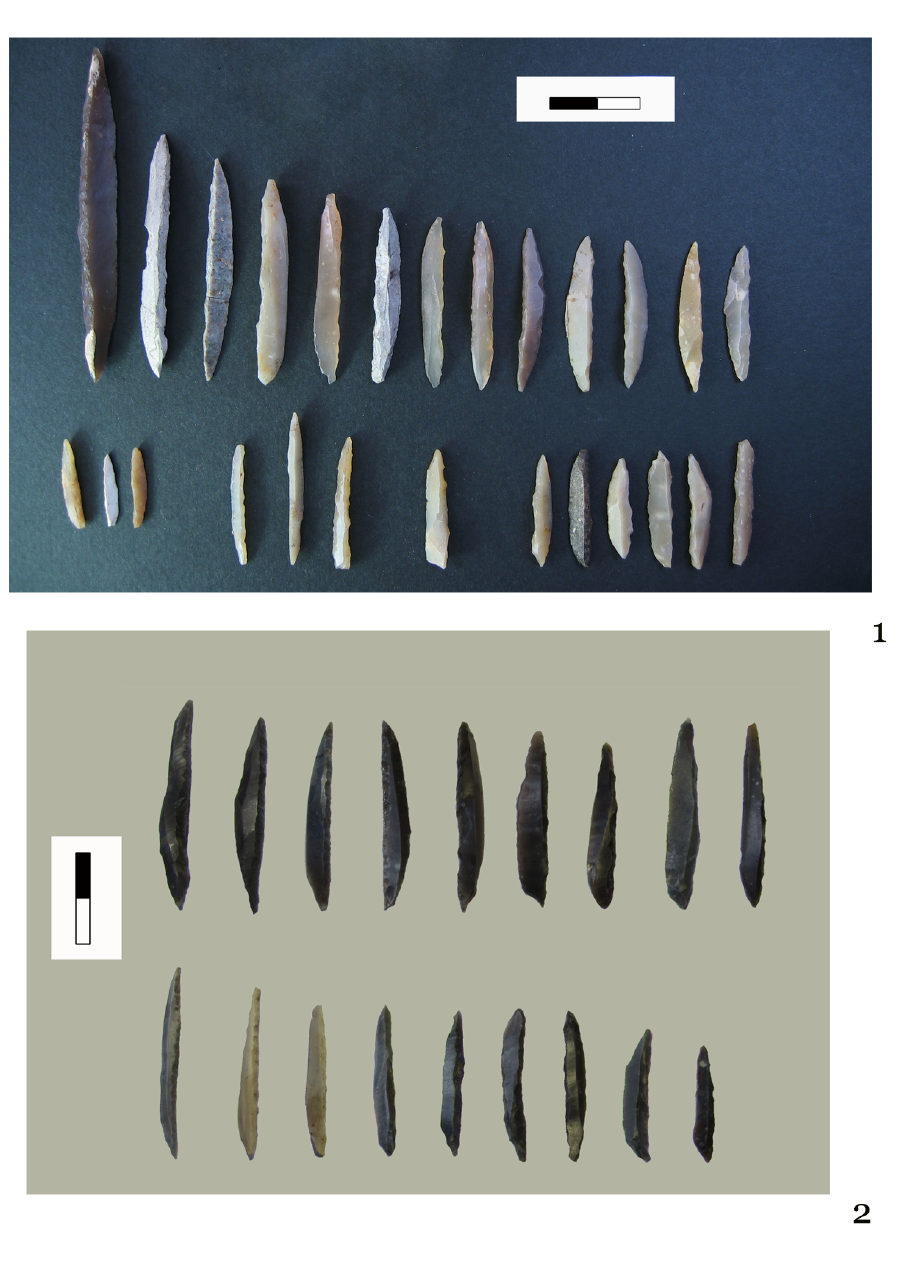
Figure 4. Backed points of 1) Grotta Paglicci (layer 22f – ph. V. Borgia) and 2) Kostenki 8 (layer II – ph. V. Borgia). Microwear analysis has shown wear traces on 15% of the entire points. Polish and linear features are generally very feeble and not diagnostic. These are located exclusively on the lateral not retouched edges, or on the basal part of some truncated points (fig. 3.2, Borgia, 2006). Another morphology of armature are the rectangular backed blades, obtained by means of fractures, which have always been mistaken for fractured pieces. These are intentional tools, as shown by some piece where the trasversal fracture is retouched (Borgia, 2006; fig.